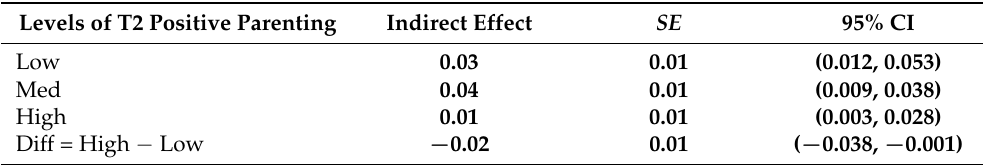
Table 4. Conditional indirect effects of T1 peer victimization on T2 risk-taking behavior via T2 self-control by levels of T2 positive